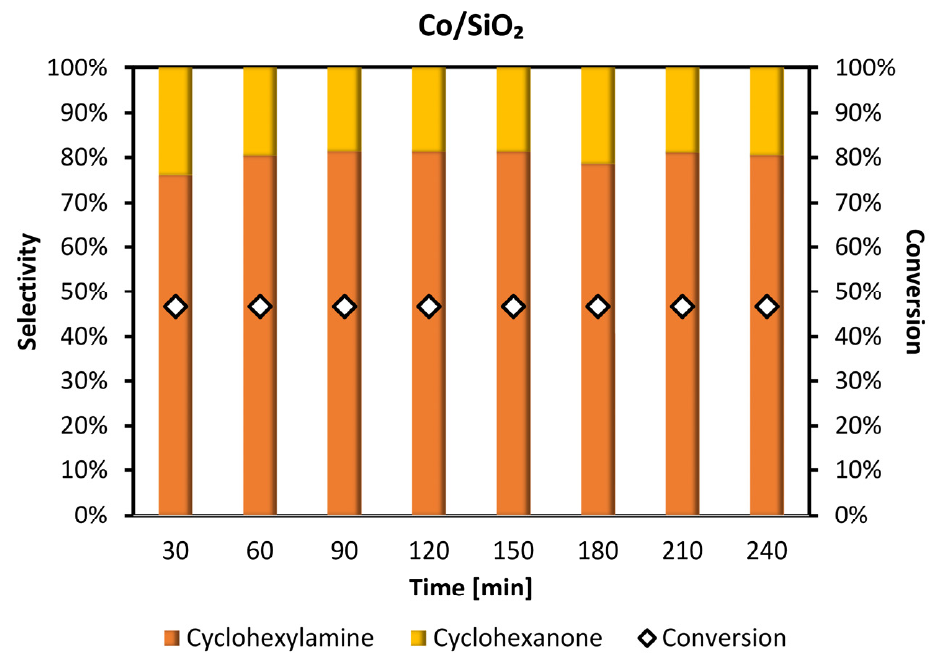
Figure 14. Catalytic hydrogenation of nitrocyclohexane in gas flow conditions with Cu/SiO 2 .